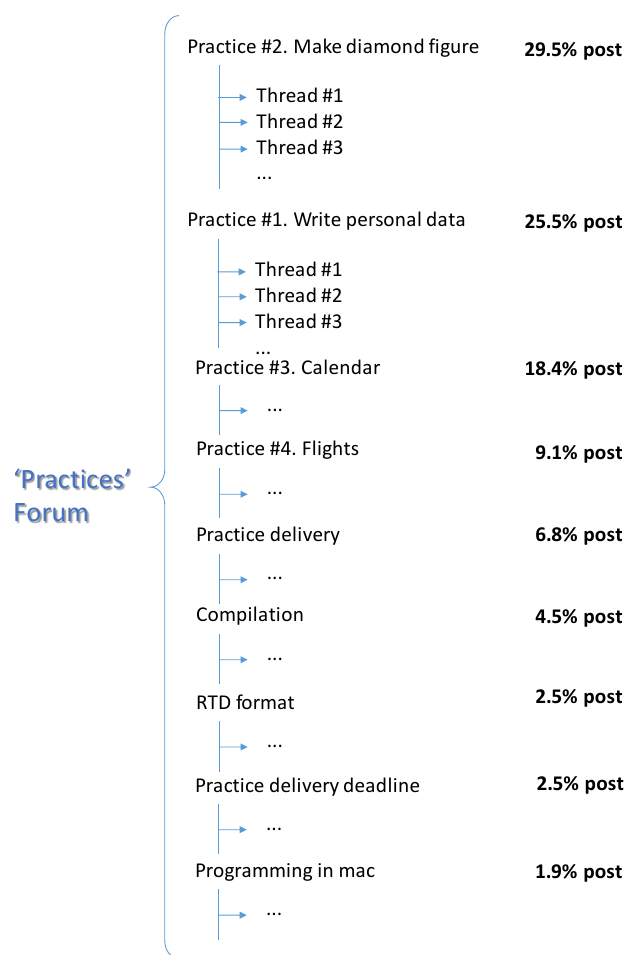
Figure 5. The main topics of the “Practices” forum category extracted by the